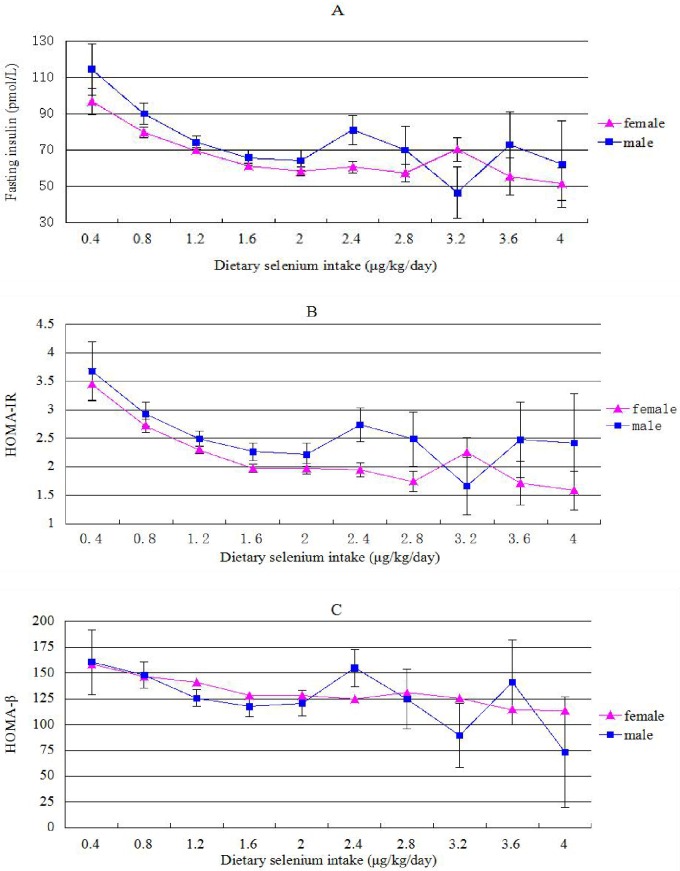
Variations in fasting insulin, HOMA-IR and HOMA-β with increasing dietary Se intake.HOMA-IR, homeostasis model assessment of insulin resistance; HOMA-β, homeostasis model assessment of β cell function.